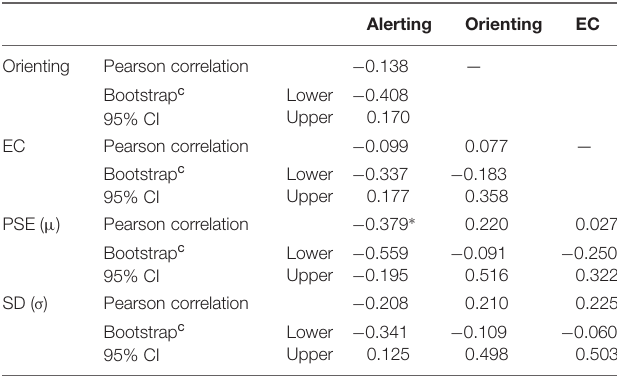
TABLE 1 | Correlations between the three functions of attentional networks in Experiment 1.